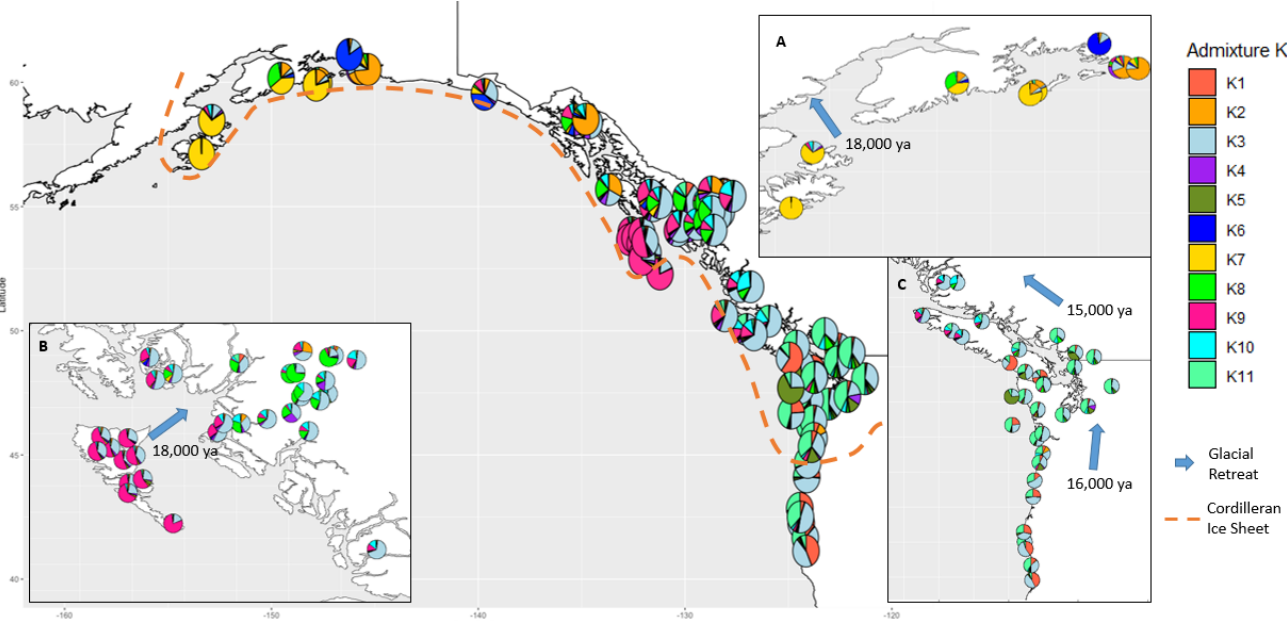
Figure 5. Genetic admixture of all 19 geographic regions of the IUFRO population for 11 ancestral populations. Optimal K (ancestral populations) for admixture is 11 based on 10 replicates of K 2-50, using a cross-validation method. Each geographic region is represented here, showing the ancestral makeup of the population.